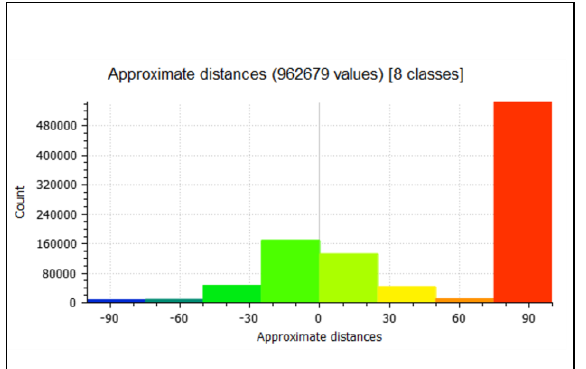
Figure 10. Histogram generated by CloudCompare software showing the classes of the values of the distances between the point cloud model and the NURBS surface defined by algorithmic Figure 7. NURBS model deriving from the algorithmic modelling.